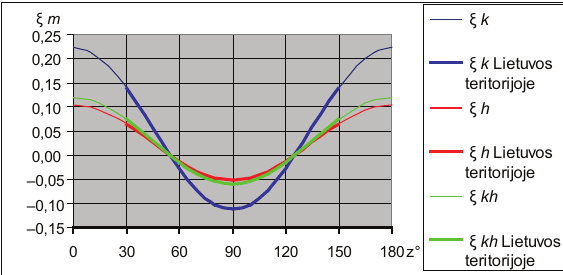
Fig. 2. Deformations of surfaces due to the Sun effect ( n = 2)